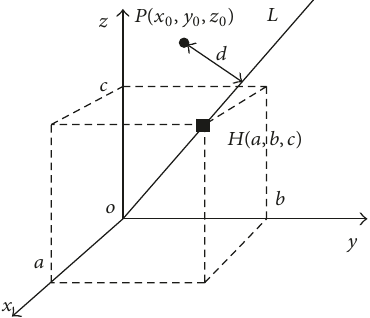
Figure 3: Distance of point to line in 3D objective